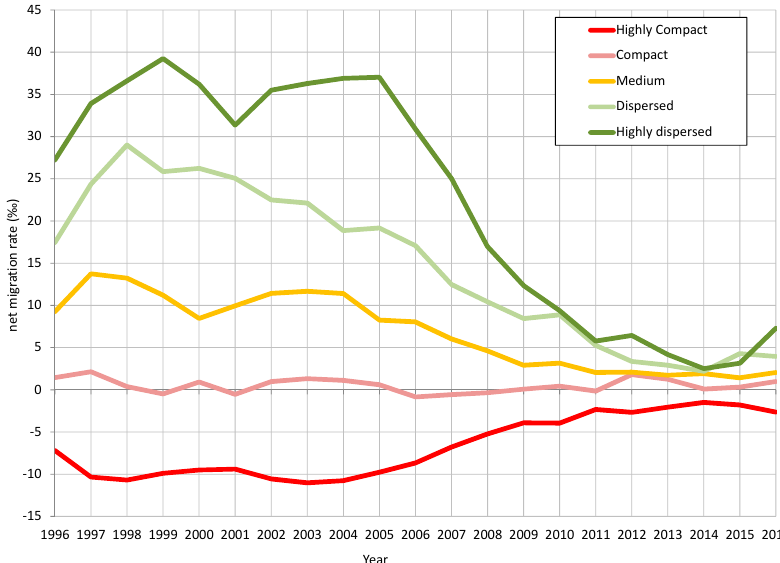
Figure 3. Net intrametropolitan migration rate by types of municipality in the BMR, 1996–2016.